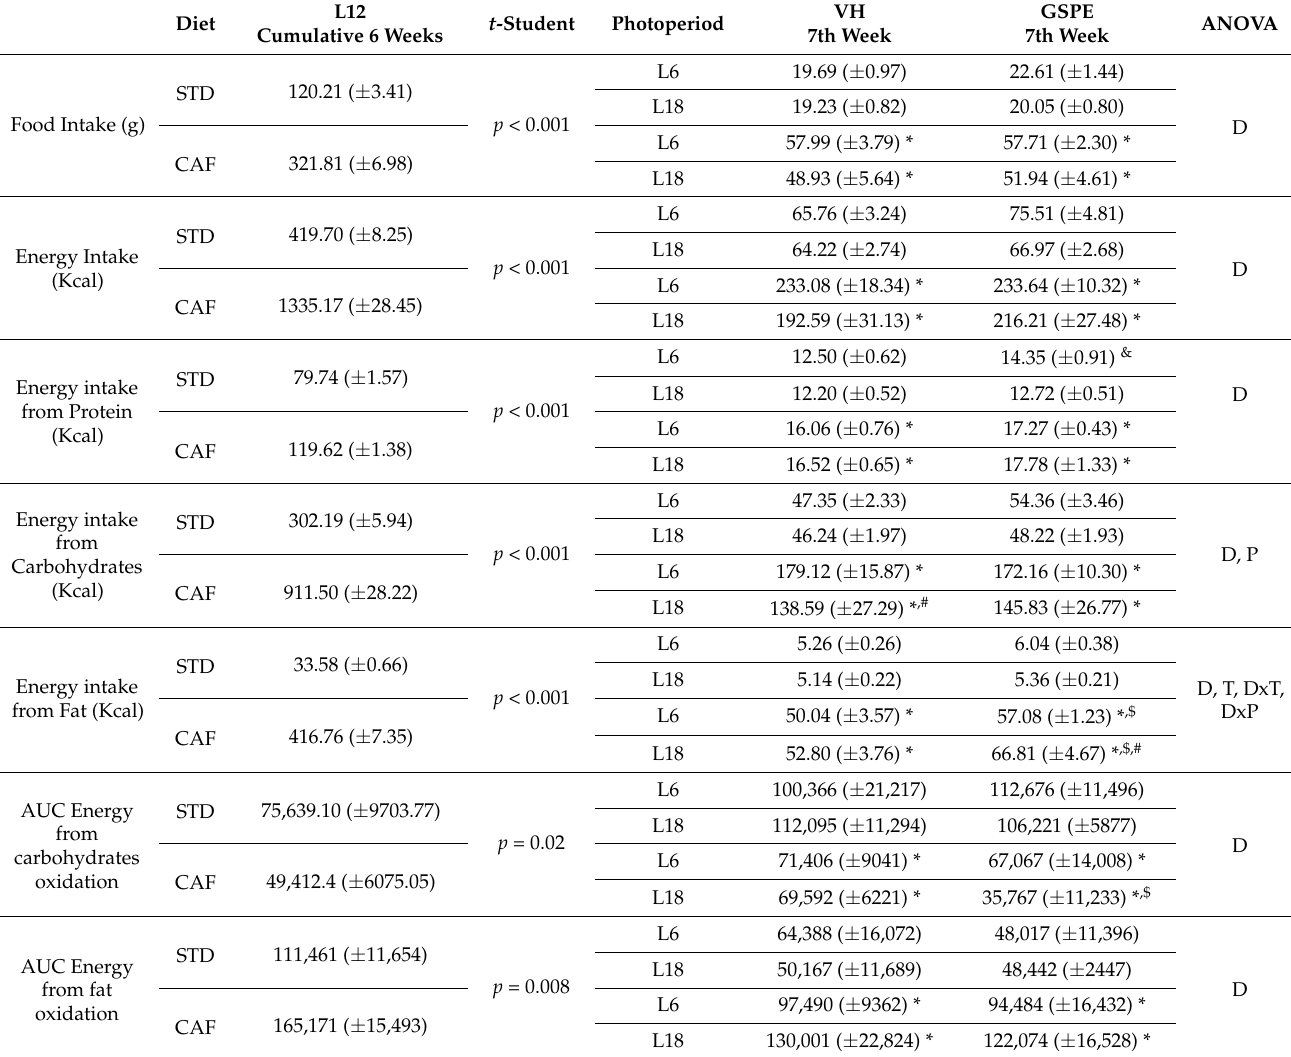
Table 1. Effect of an abrupt change in the photoperiod and grape seed proanthocyanidins administra- tion on cumulative food and energy intake over the six weeks under L12 conditions and the seventh week of experiment under L18 and L6